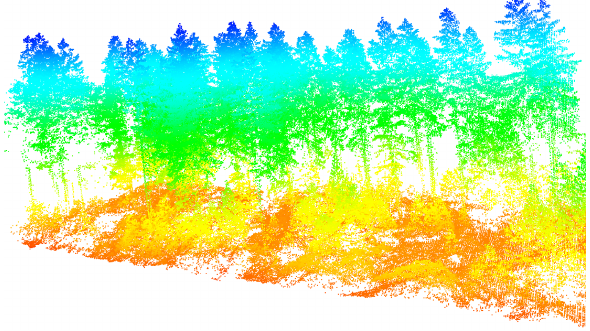
Figure 5. A point cloud visualization of sample forest scene with multiple visible stems (point clouds of scene colored by height over DTM).